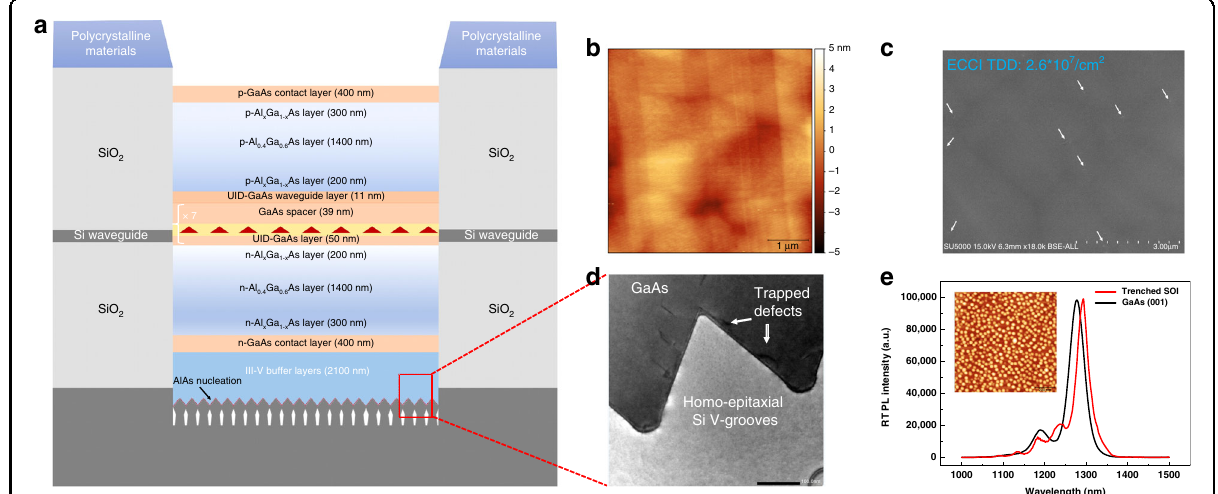
Fig. 3 Epitaxial growth structures and material characterization. a Schematic of the laser epi-structures. b Surface AFM image of 2100 nm thick III-V buffer layers grown on trenched SOI before epitaxial growth of laser sturctures (RMS ~ 0.8 nm). c TDD estimated from ECCI image (2.6 ×10 7 /cm 2 ). d Cross-sectional TEM image of as-grown GaAs/Si interface on trenched region of SOI substrate. e PL spectra comparison between InAs QDs grown on trenched SOI substrate and standard GaAs substrate under identical conditions. Inset: AFM image of surface InAs QDs on trenched